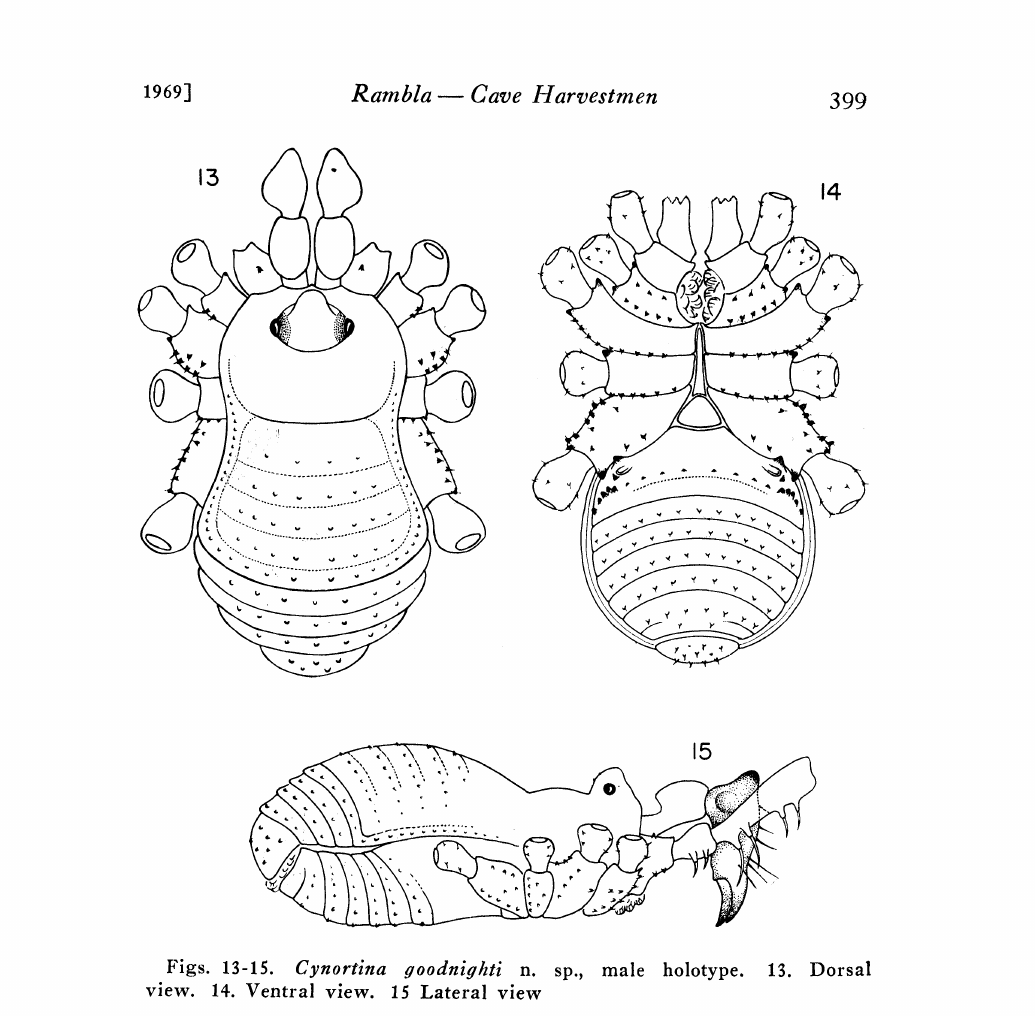
Figs. 13-15. Cynortina 7oodniThti n. sp., male holotype. 13. Dorsal view. 14. Ventral view. 15 Lateral view surface of coxa IV is covered with bigger tubercles more o.r less arranged in